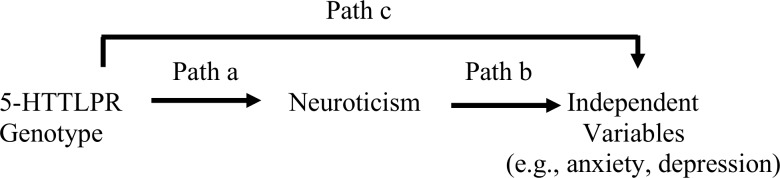
Paths in mediation model.